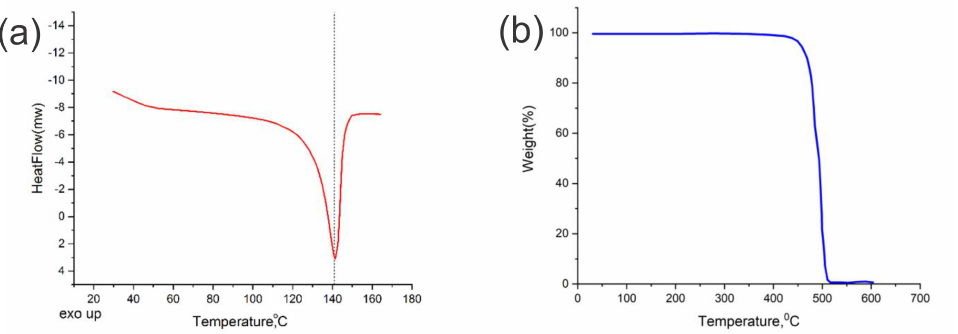
Figure 10. ( a ) Differential scanning calorimetry of UHMWPE powder. ( b ) Thermogravimetric analysis of